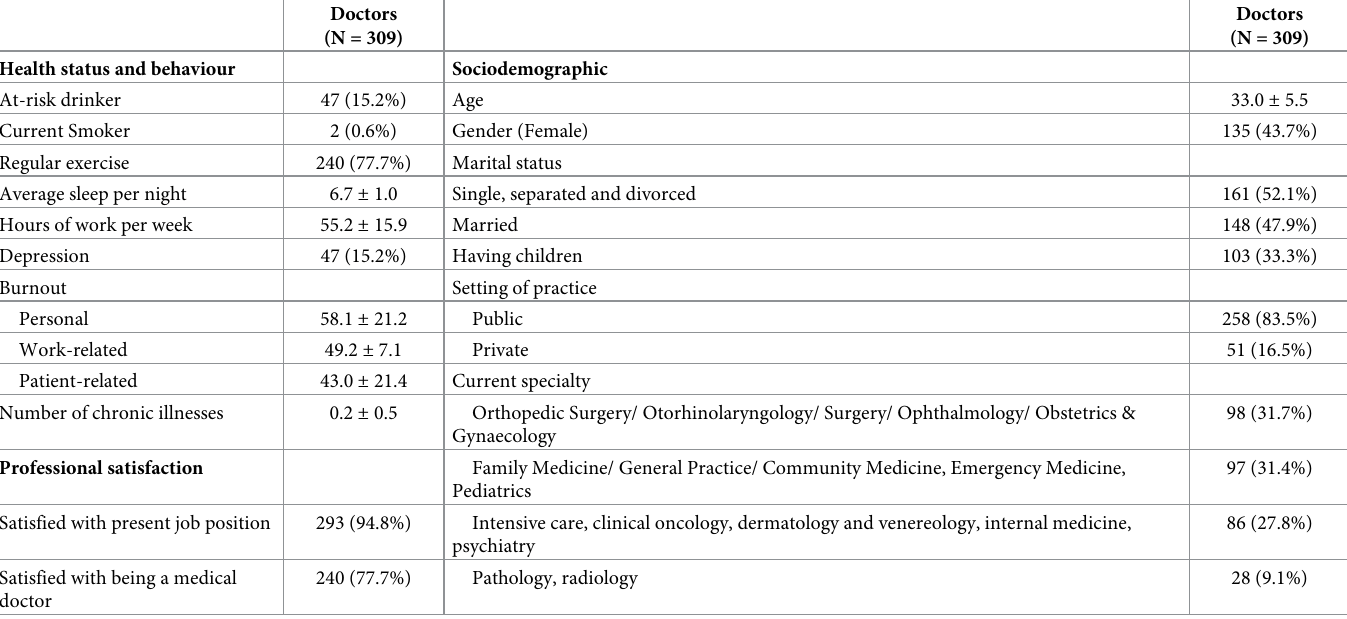
Table 1. Descriptive statistics on sociodemographic, professional satisfaction, and health